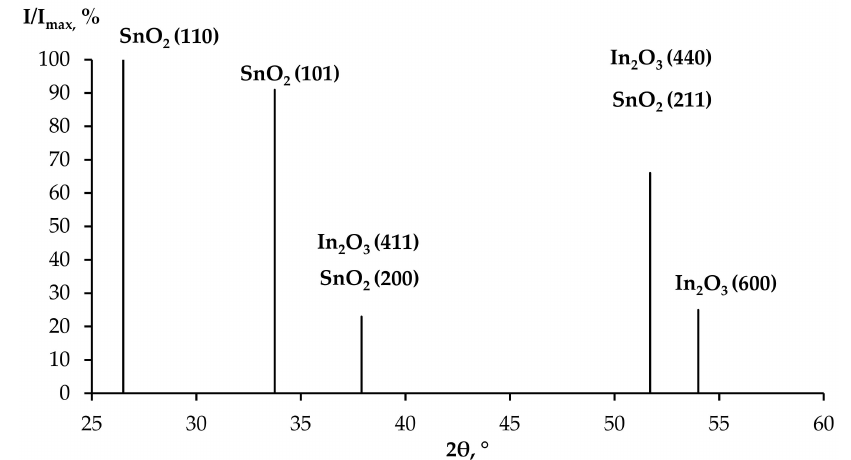
Figure 11. Typical XRD pattern (after thermal treatment at 700 ◦